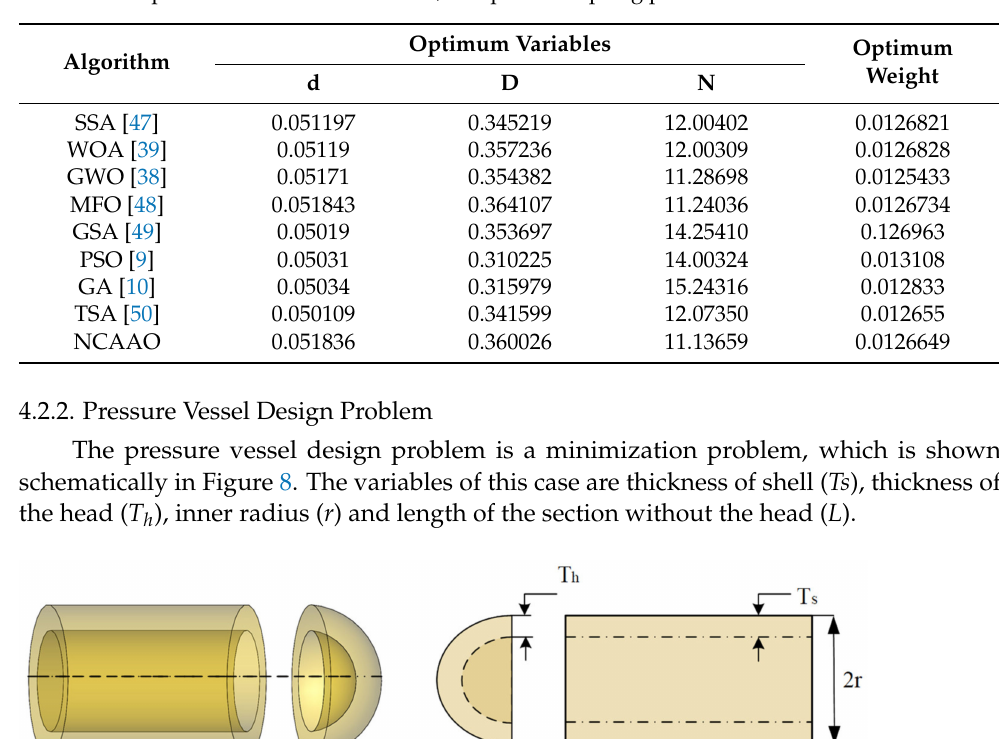
Table 9. Comparison of results for tension/compression spring